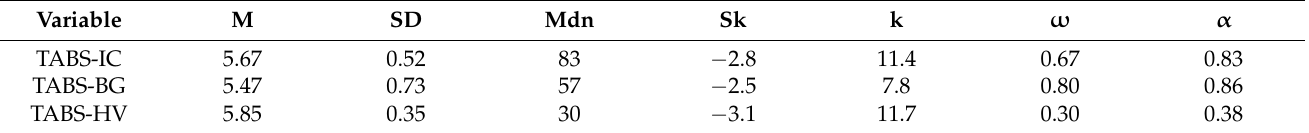
Table 2. Sum scores and internal consistency